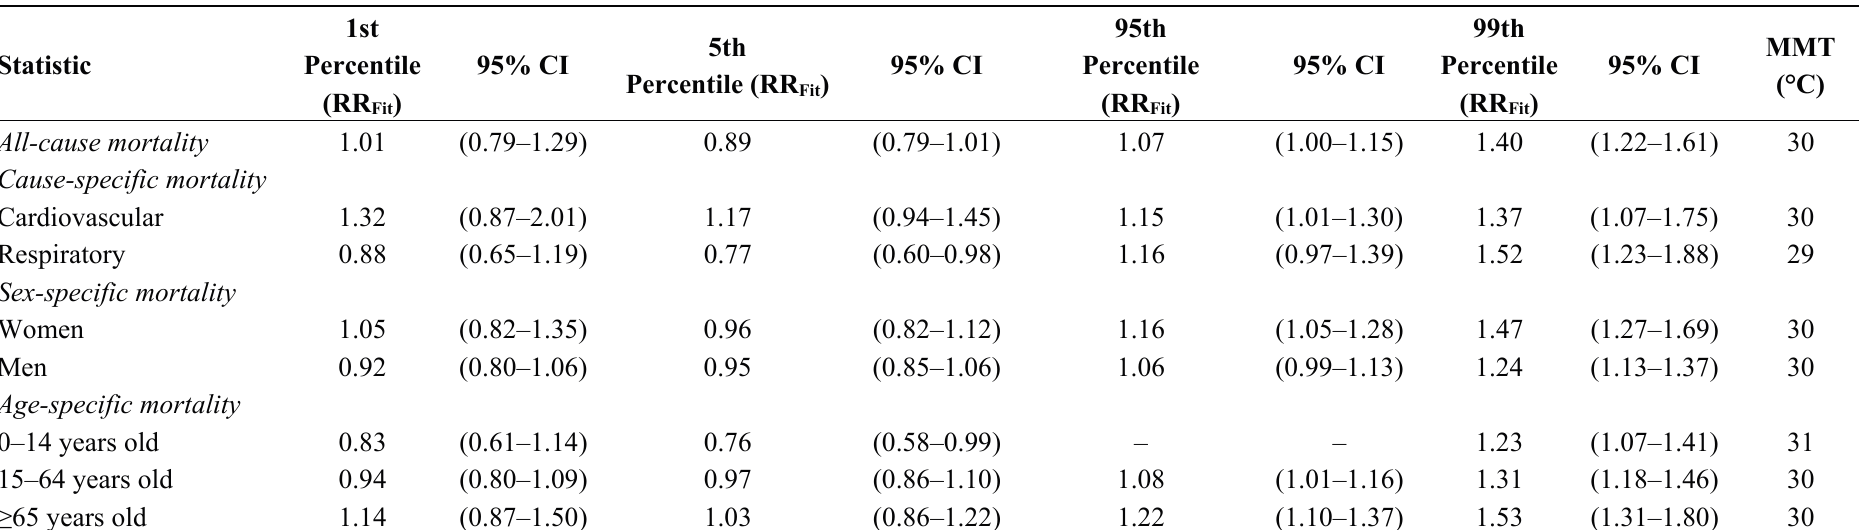
Table 2. The NCS-NCS RR of category-specific mortality in the 1st, 5th, 95th, and 99th temperature percentiles and respective